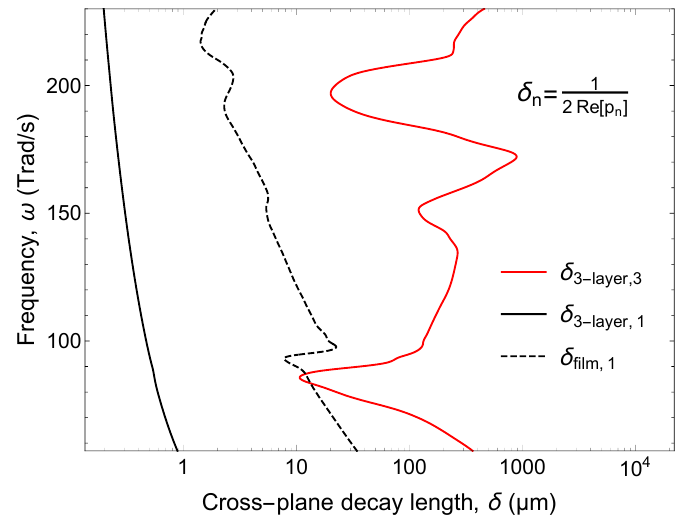
Figure 6. Cross-plane decay length in different media: Si (red solid line) and vacuum (black solid line) of the three-layer structure, and vacuum in the vicinity of the single film structure (black dashed line).